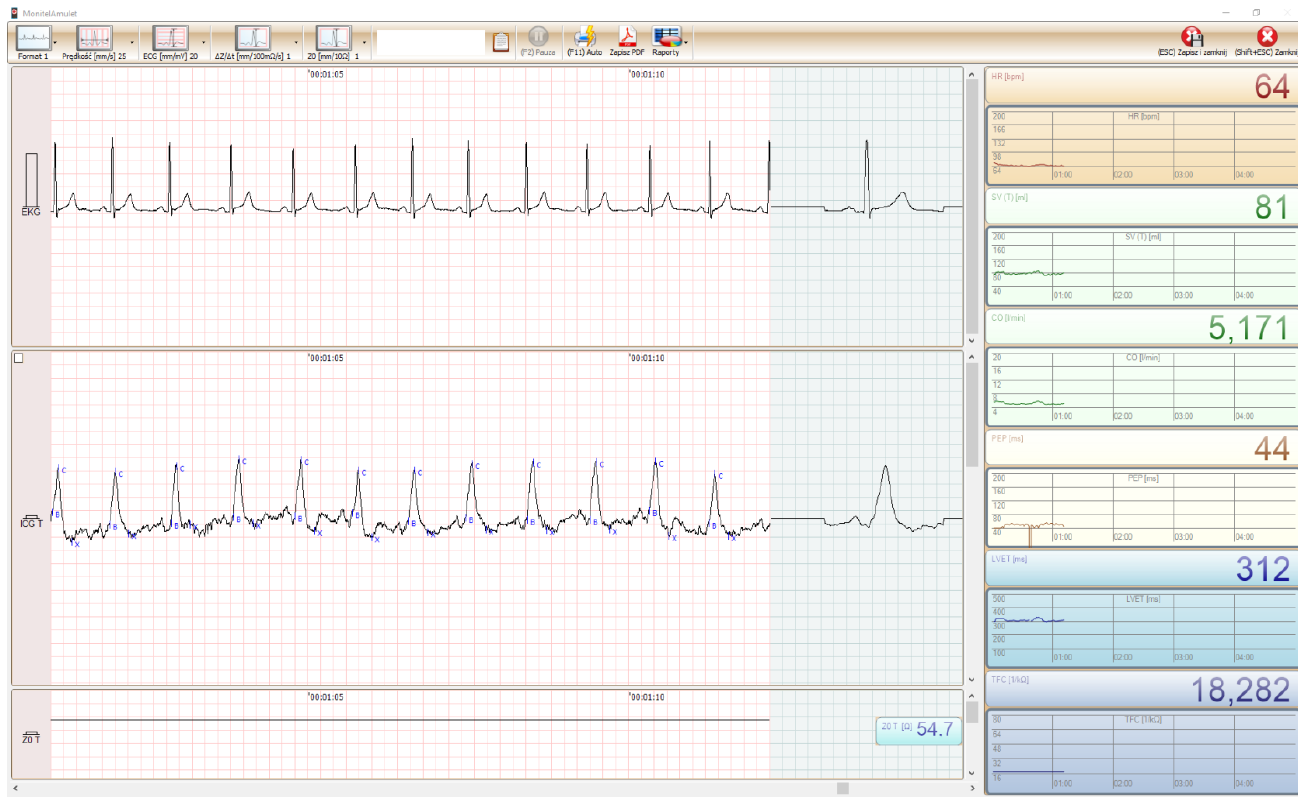
Figure 4. Screen of the graphic user interface of 4hearts